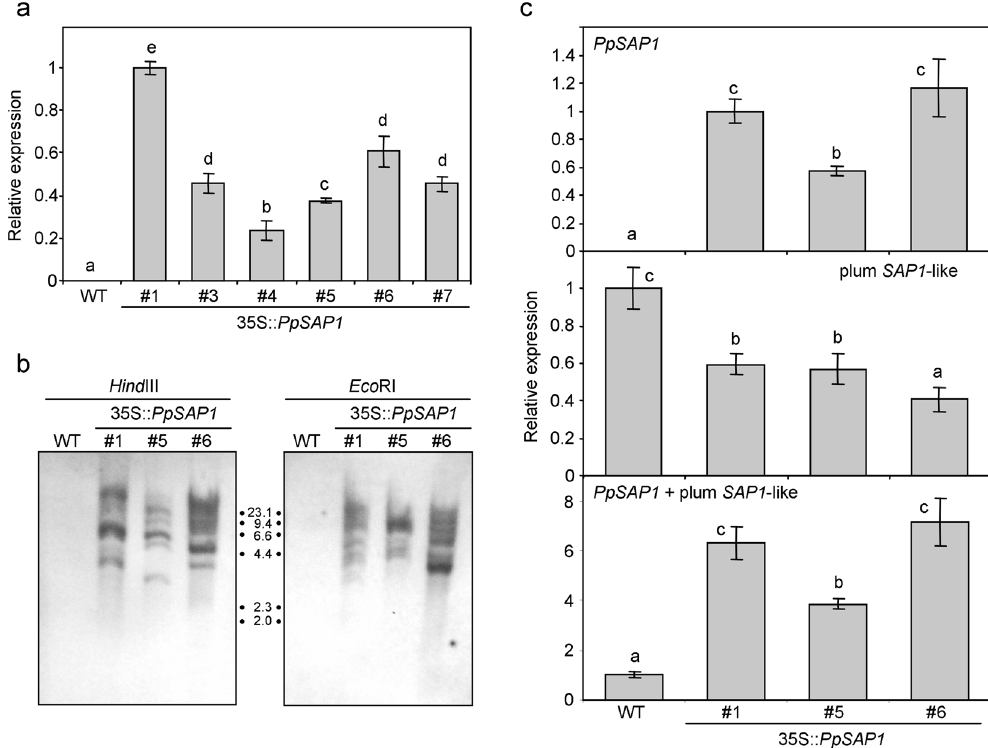
Figure 5. Overexpression of PpSAP1 in transgenic plum. In ( a ), heterologous expression of PpSAP1 in six independent transgenic lines of plum (35S:: PpSAP1 #1, #3, #4, #5, #6, #7) and the wild type (WT). Southern analysis with restriction enzymes Hind III and Eco RI of WT and transgenic lines #1, #5, #6 ( b ), showing the position of molecular weight markers (kb). In ( c ), the relative expression of PpSAP1 , plum SAP1 -like and both genes ( PpSAP1 + plum SAP1 -like) is shown for three transgenic lines, by using specific primers. An expression value of one is assigned to the WT or the transgenic line #1. Data are means from three biological samples with two technical replicates each, with error bars representing standard deviation. Different letters ( a – e ) indicate significant difference between samples with a confidence level of